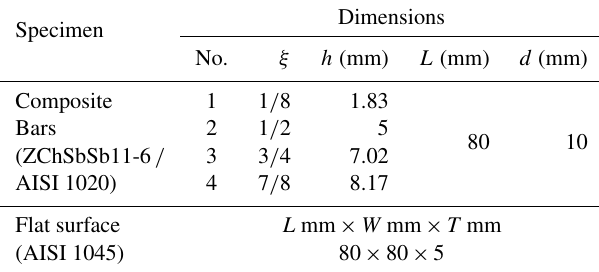
Figure 6. Microscopic characterization of specimens.